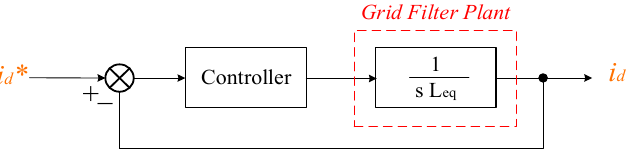
Figure 14. The simplified current control loop of a grid-connected power converter.